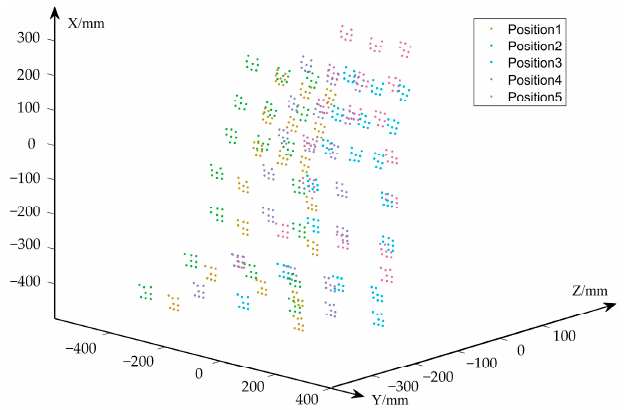
Figure 17. Reconstruction results of the repeatability veri fi cation experiment.